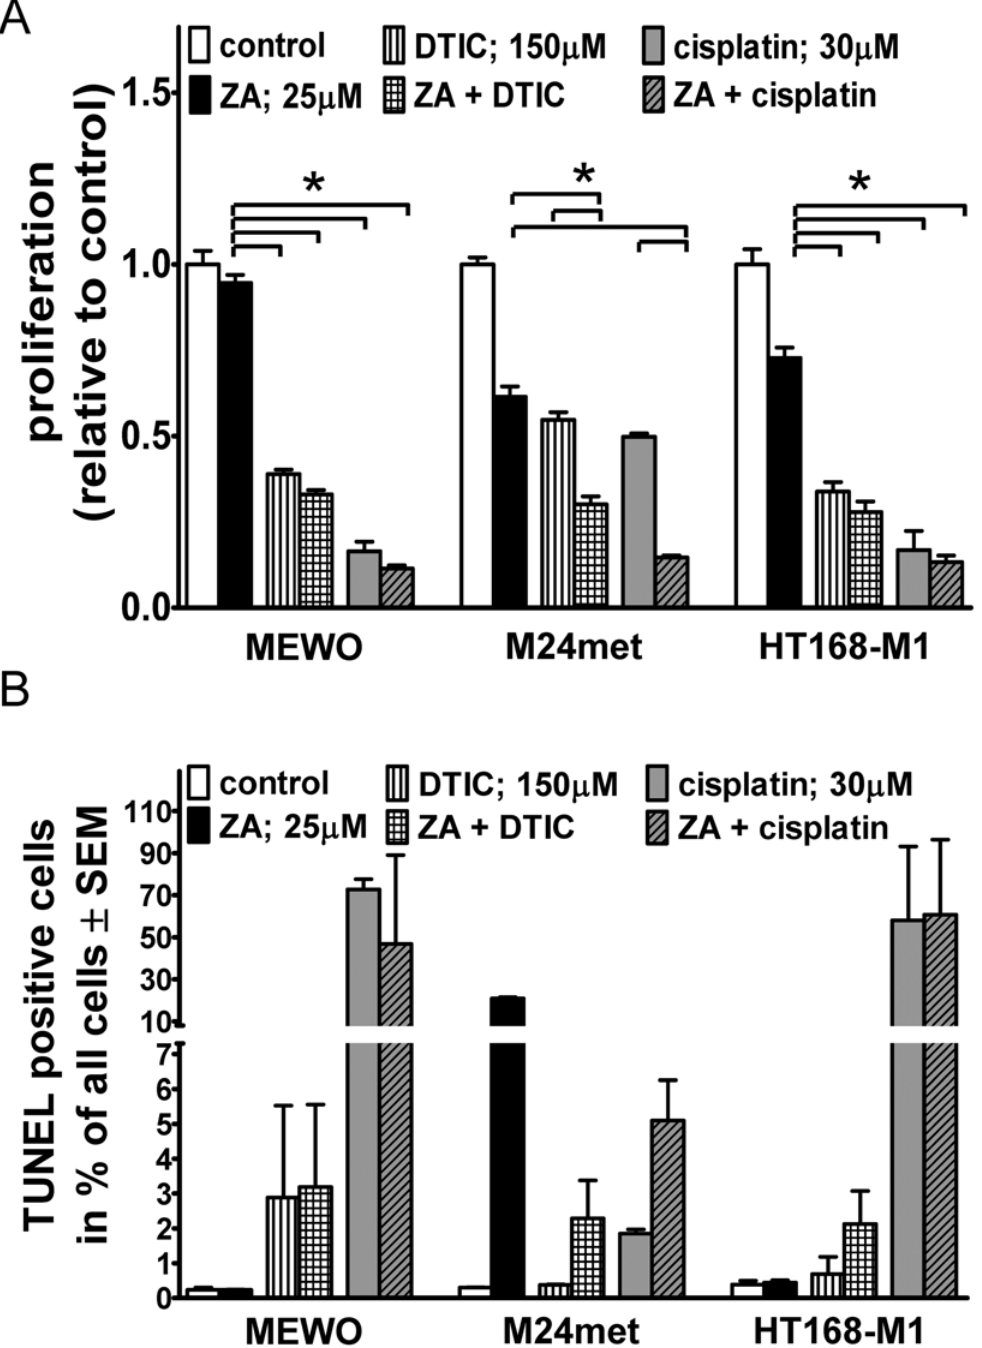
Fig 4. Proliferation and apoptosis in melanoma cells after combination treatments. ( A ) Both cytotoxic compounds reduced proliferation significantly after 48hs of treatment in three cell lines irrespective of oncogenic mutation using SRB assay. An additive effect of ZA and cytotoxic treatment was measured in the NRAS mutant M24met cells. ( B ) Proportion of TUNEL positive cells after combined treatment with ZA and standard cytotoxic therapy (DTIC or cisplatin). No synergism was observed in any of the cell lines investigated. Data shown as average ± SEM are results of four independent measurements. Asterisks indicate significance of p < 0.05 with Kruskal-Wallis and Dunn ’ s multiple comparison tests.